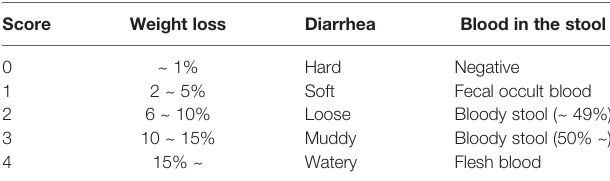
TABLE 1 | Criteria of clinical